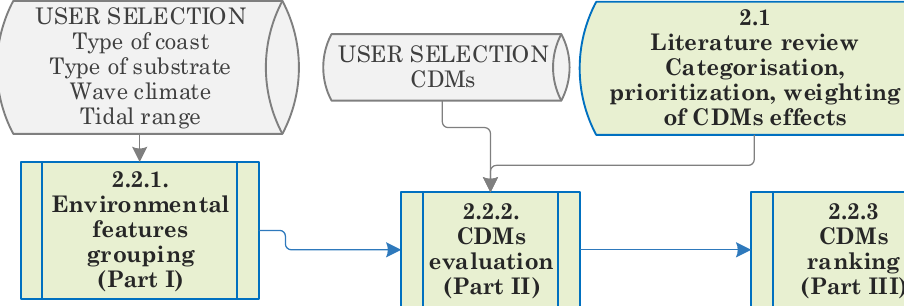
Figure 1. Graphical synthesis of the CDMIA.